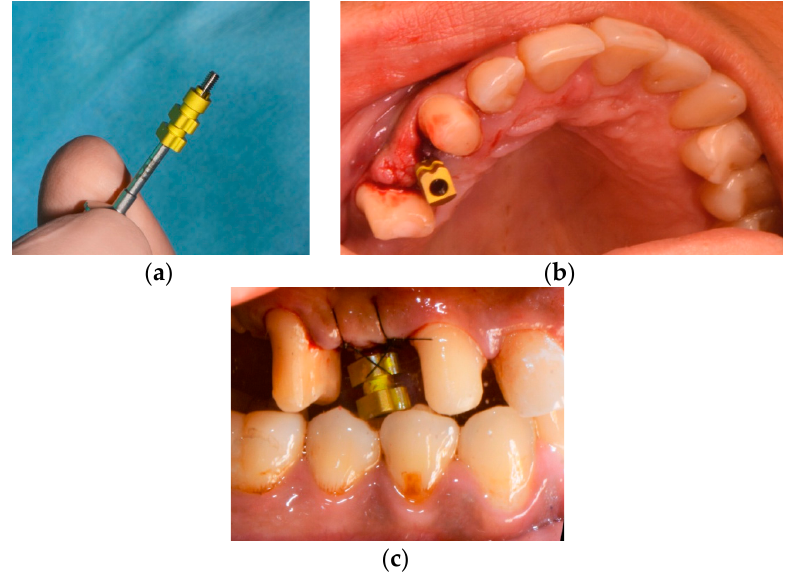
Figure 10. ( a ) Picking up the ScanPost; ( b ) inserted ScanPost; ( c ) inserted SscanPost with an adapted single suture for repositioning the mucoperiosteal flap .